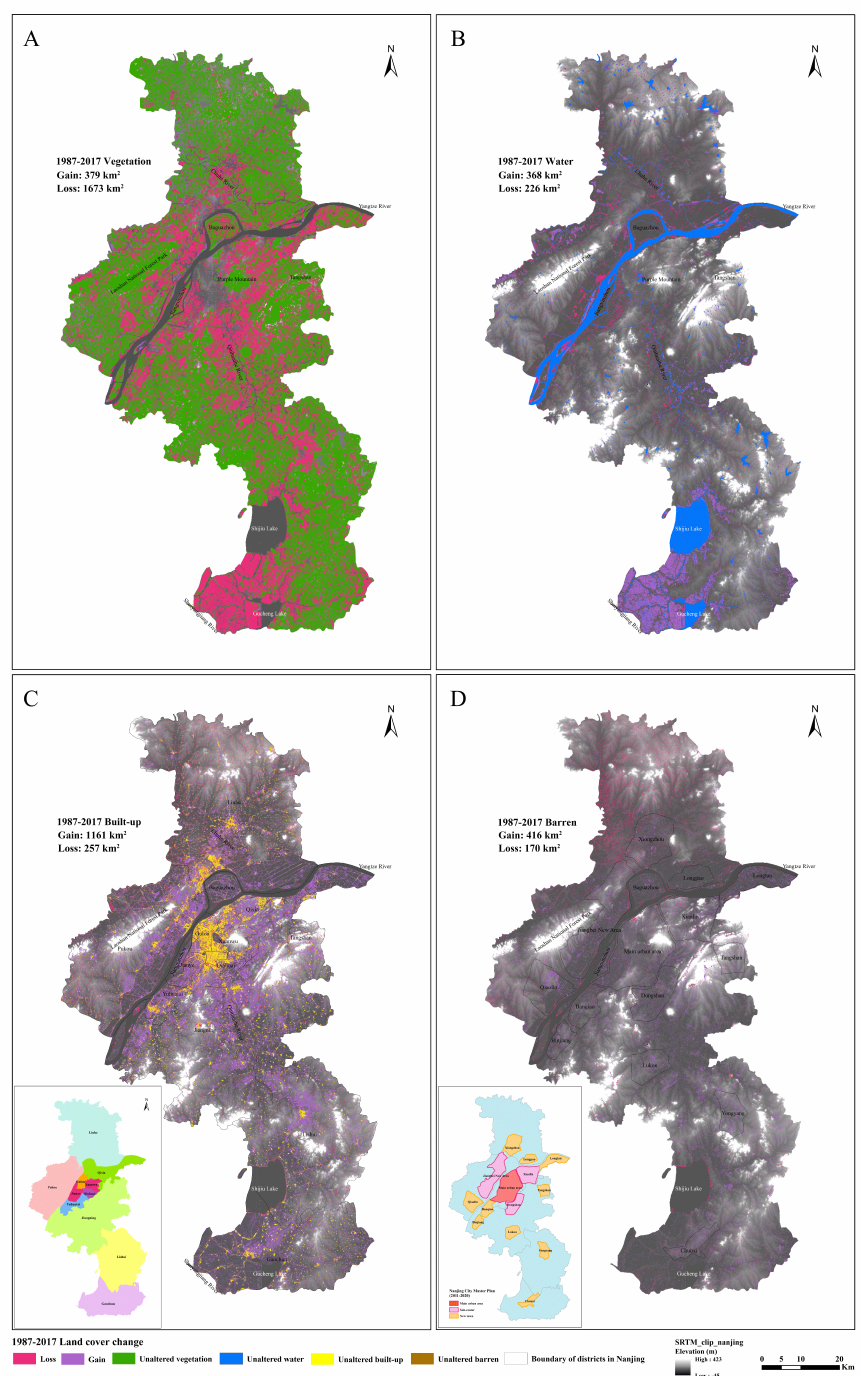
Figure8. Spatialdistributionofland-use / land-cover(LULC)changebetweentheclassifiedcompositesin 1987–1989 and 2015–2017 using a grayscale topography (SRTM 30 m spatial resolution): ( A ) vegetation, ( B ) water, ( C ) built-up area (the illustration is the administrative division of Nanjing), and ( D ) barren land. The lower-left corner shows the master plan of Nanjing. Loss indicates that the land-cover category was converted to other land-cover categories, while Gain shows that other land-use types were transferred to the given land-cover